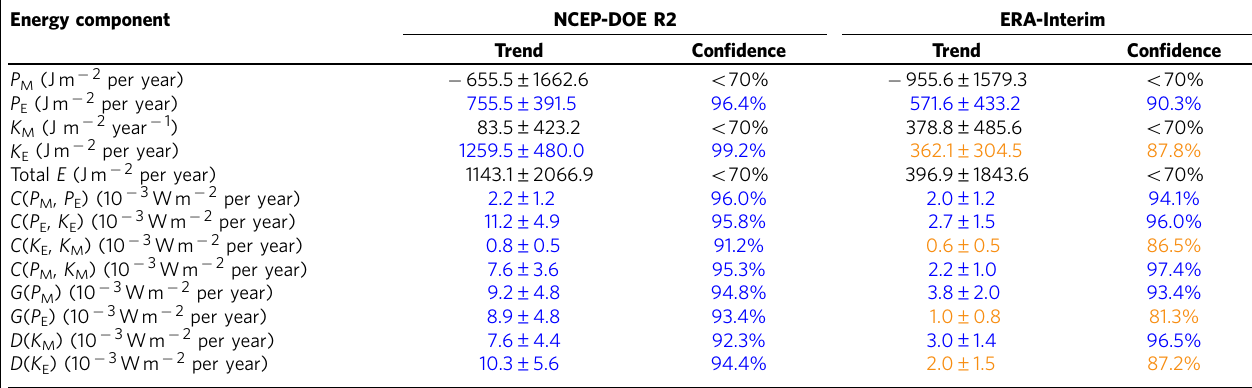
Table 1 | Linear trends and the corresponding confidence levels of energy components of the Lorenz energy cycle of the global atmosphere 1979–2013.